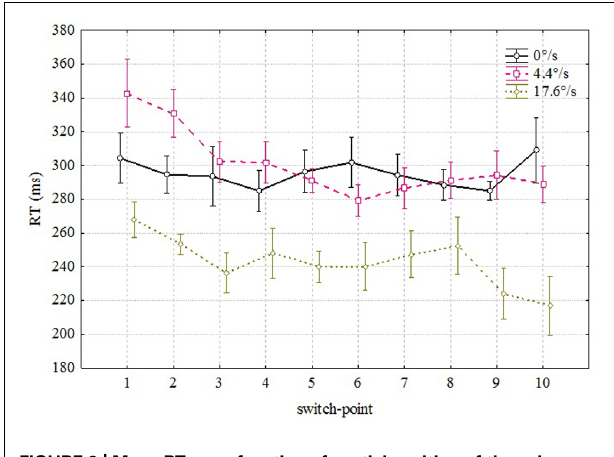
FIGURE 2 | Mean RTs as a function of spatial position of the color change along the movement trajectory. Vertical bars denote ± standard